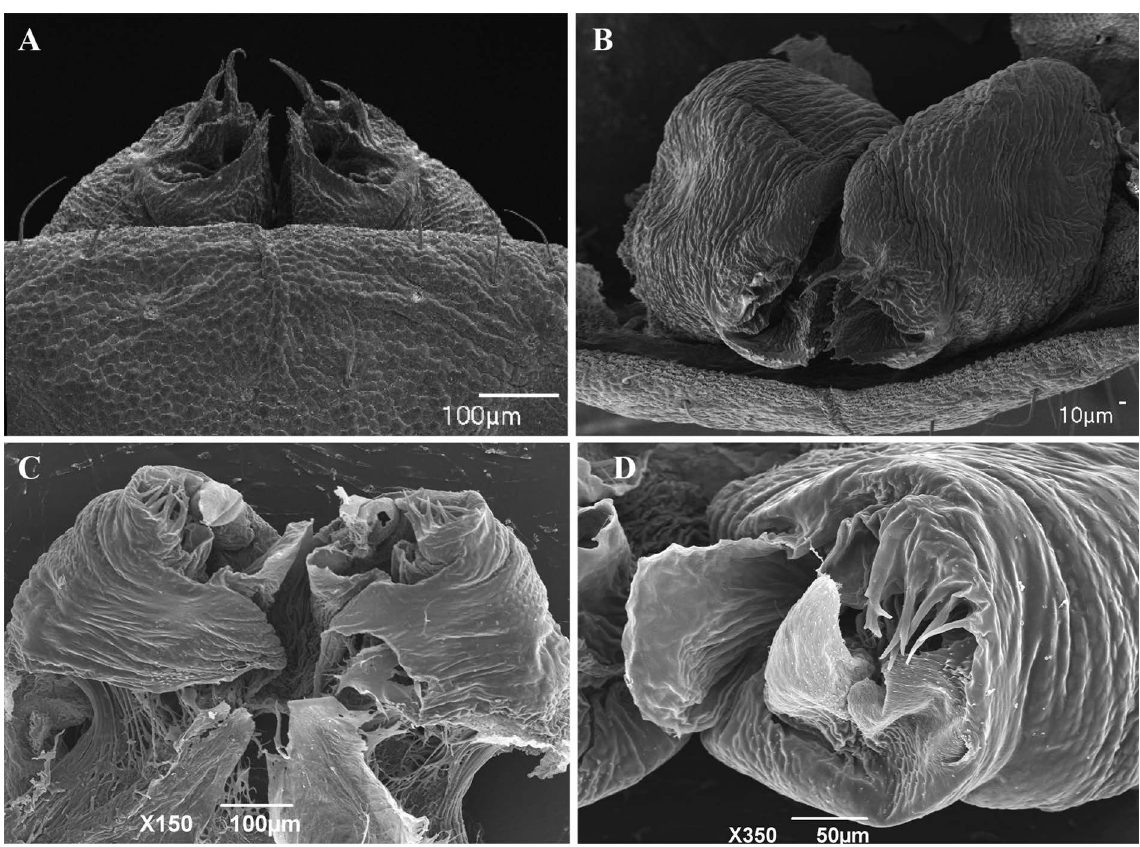
Fig. 9. Charinus Simon, 1892, male gonopods. A–B . Charinus euclidesi sp. nov. (MNRJ 9099), ventral view (A), posterior view (B). C–D . Charinus sooretama sp. nov. (MNRJ 9245), ventral view (B), detail of sinistral side showing lamina medialis, lateral lobe 1 and 2, and dorsal